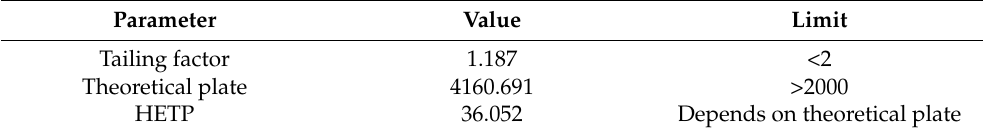
Table 4. System suitability results for XH.